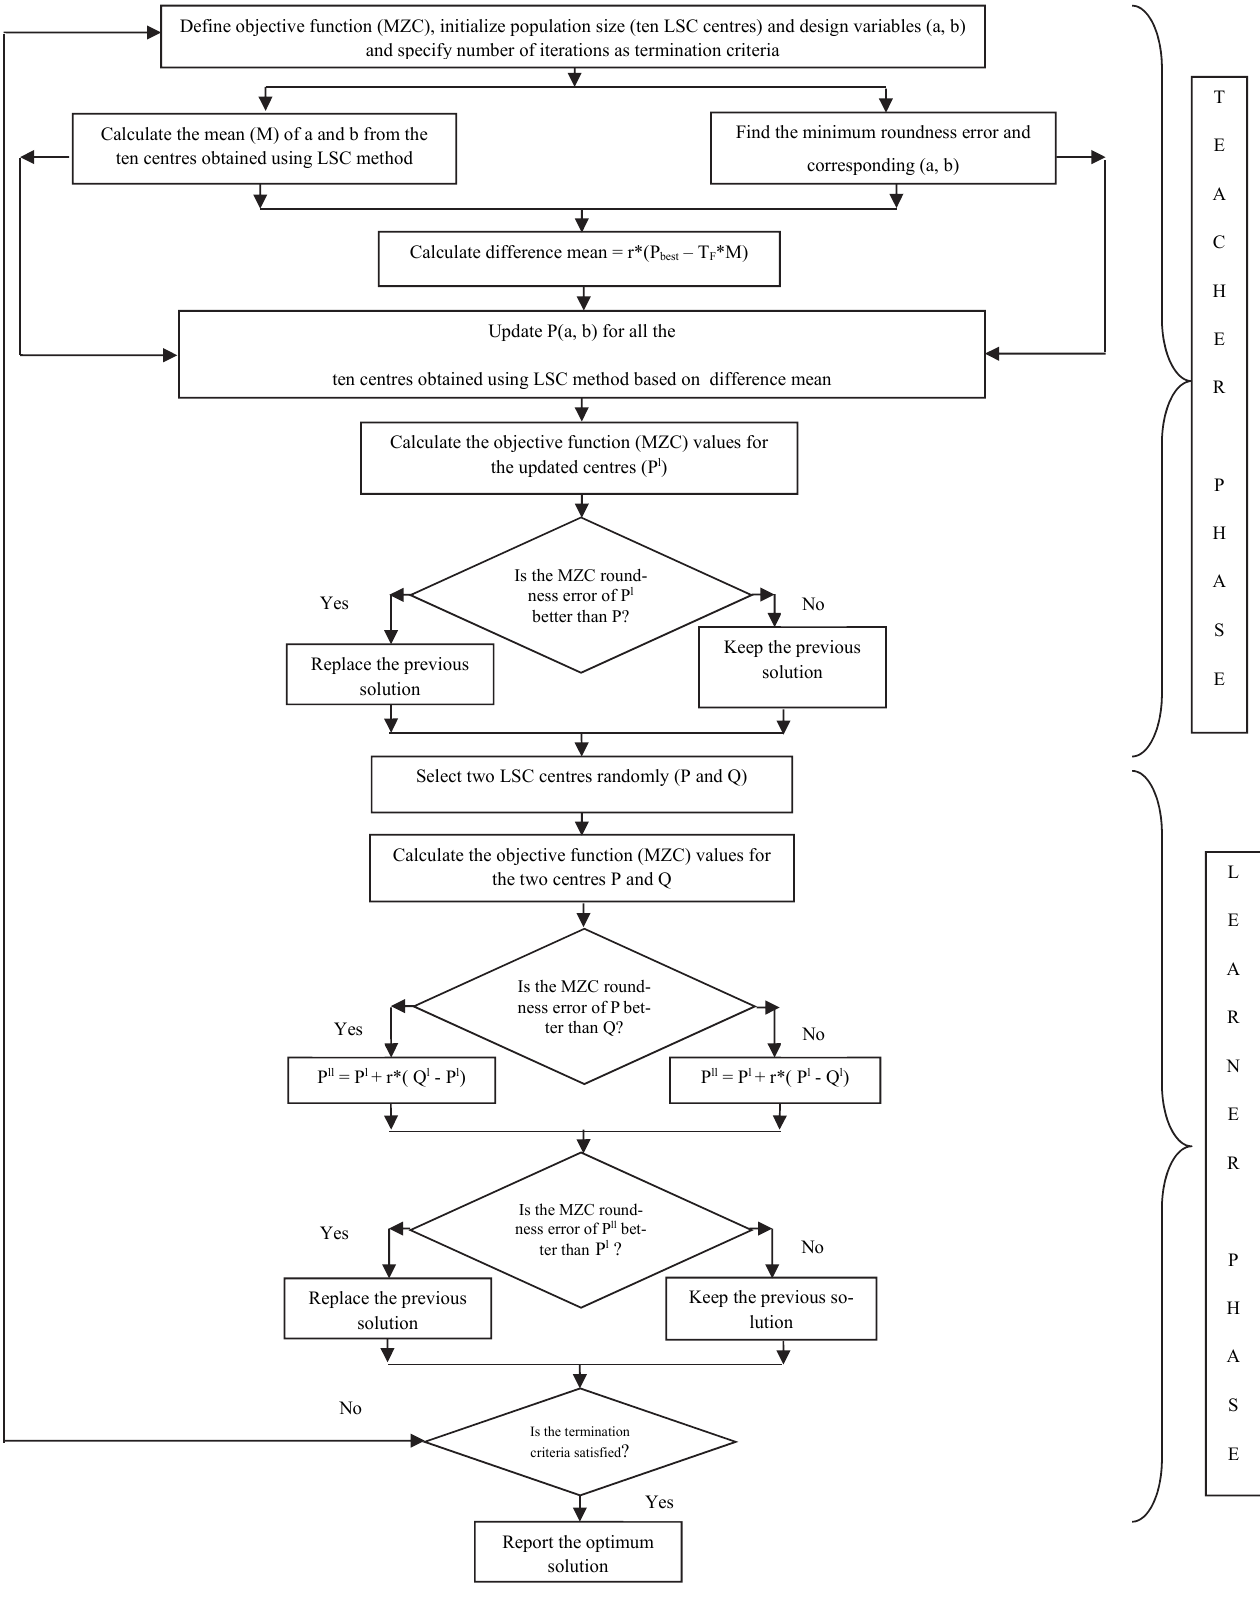
Fig. 1. Implementation flowchart of TLBO